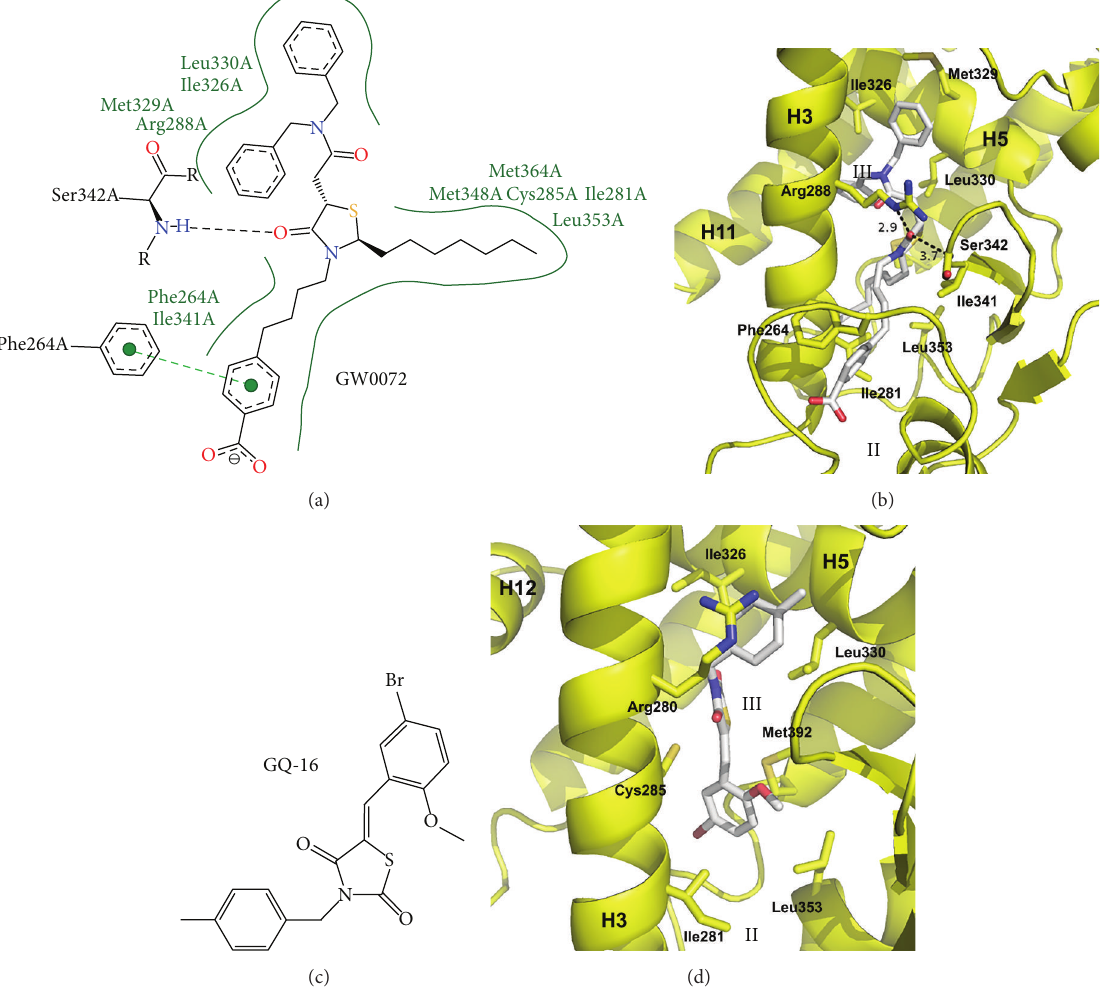
Figure7:CrystalstructuresofthiazolidinecontainingPPAR 𝛾 partialagonists.(a)PoseviewmapofGW0072.(b)CrystalstructureofGW0072 bound to the PPAR 𝛾 ligand binding domain. PDB: 4PRG [41]. (c) Chemical diagram of GQ-16. (d) Crystal structure of GQ-16 bound to